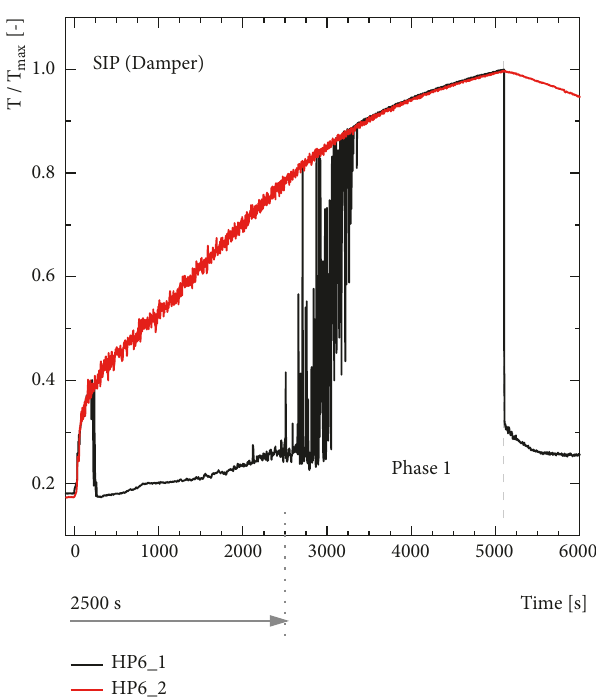
Figure 4: Normalized temperature signal at the orifice (SIP.1 in Figure 3) for experiments HP6 1 and HP6 2. Temperature is normalized with maximum